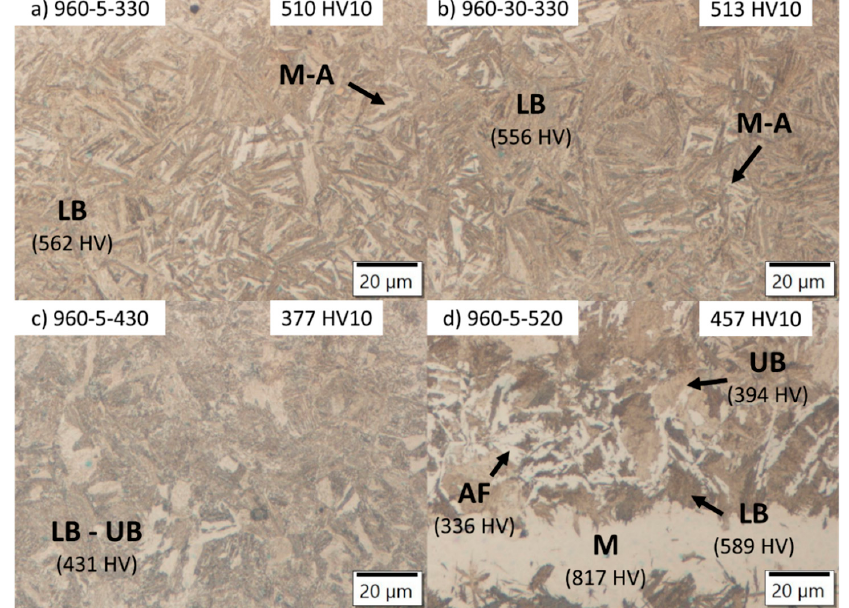
Figure 10. Optical microscopy of etched samples at 500× magnification after different heat treat- ments. ( a ) Austenitisation at 960 °C for 5 min followed by bainite transformation at 330 °C, ( b )